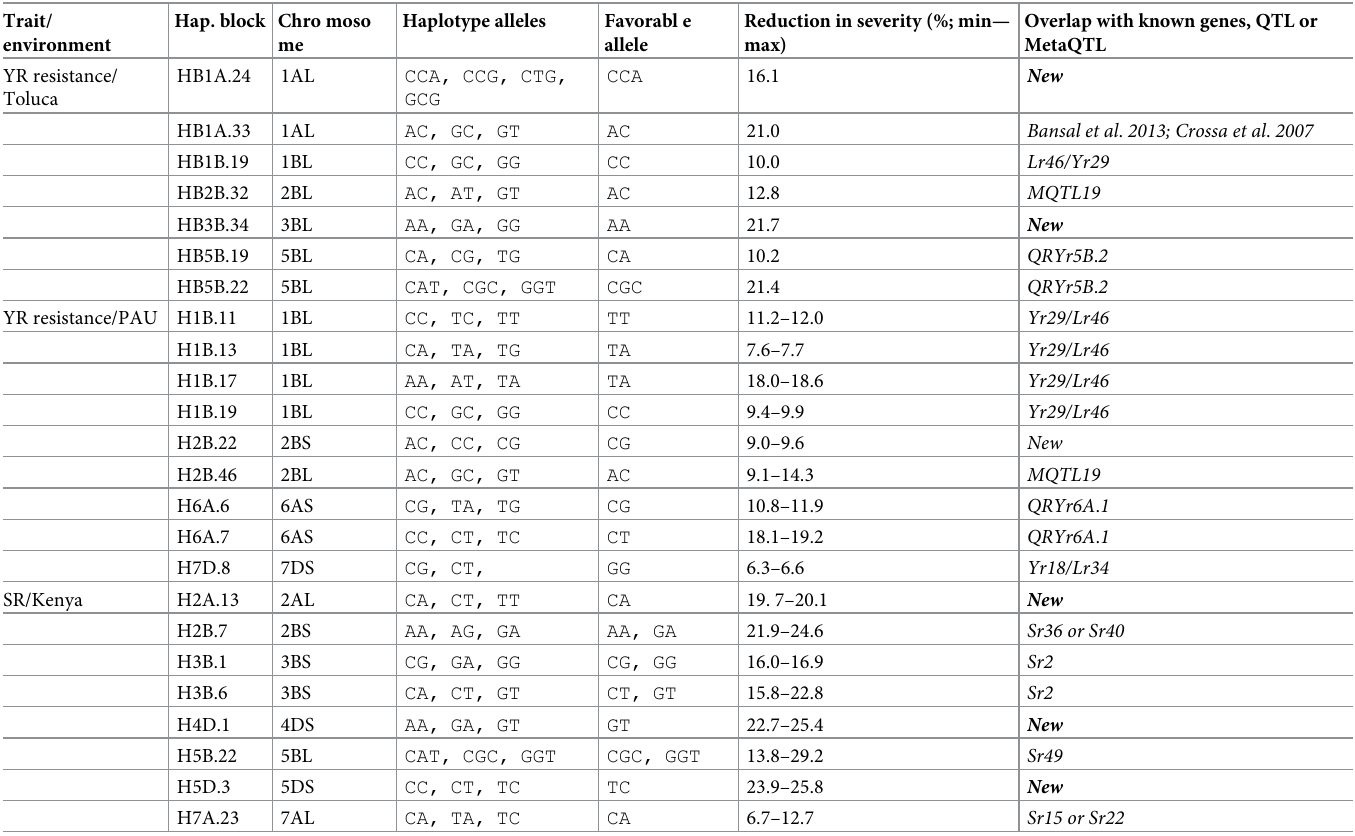
Table 1. Important haplotype associations with yellow and stem rust resistance. Trait/ environment